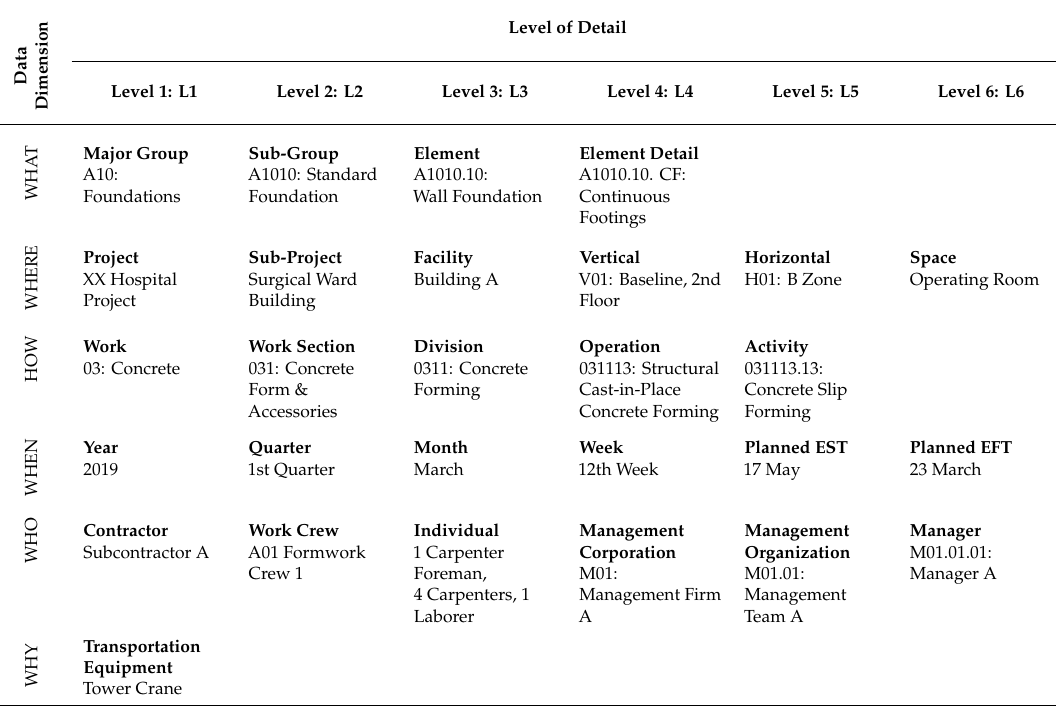
Table 1. Information units of Six Dimensions at Levels of Detail (adopted from Cho et al.